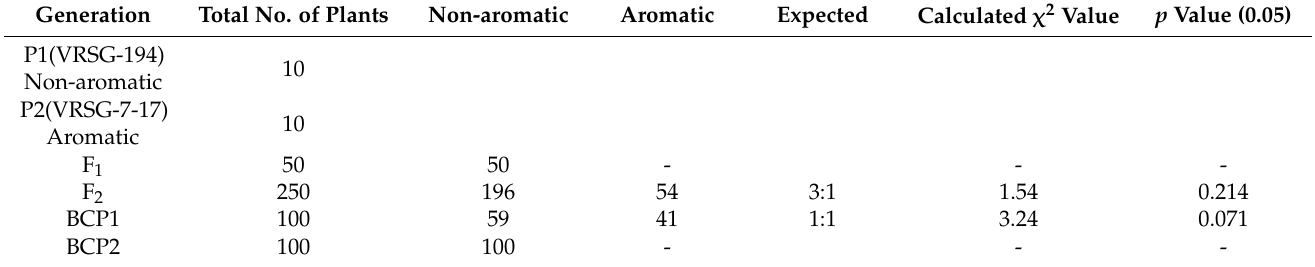
Table 1. Observed segregation ratio and the Chi-square ( χ 2 ) value for the goodness-of-fit to mono- genic model for F 2 and test cross population derived from a cross between aromatic and non-aro- matic Luffa lines.